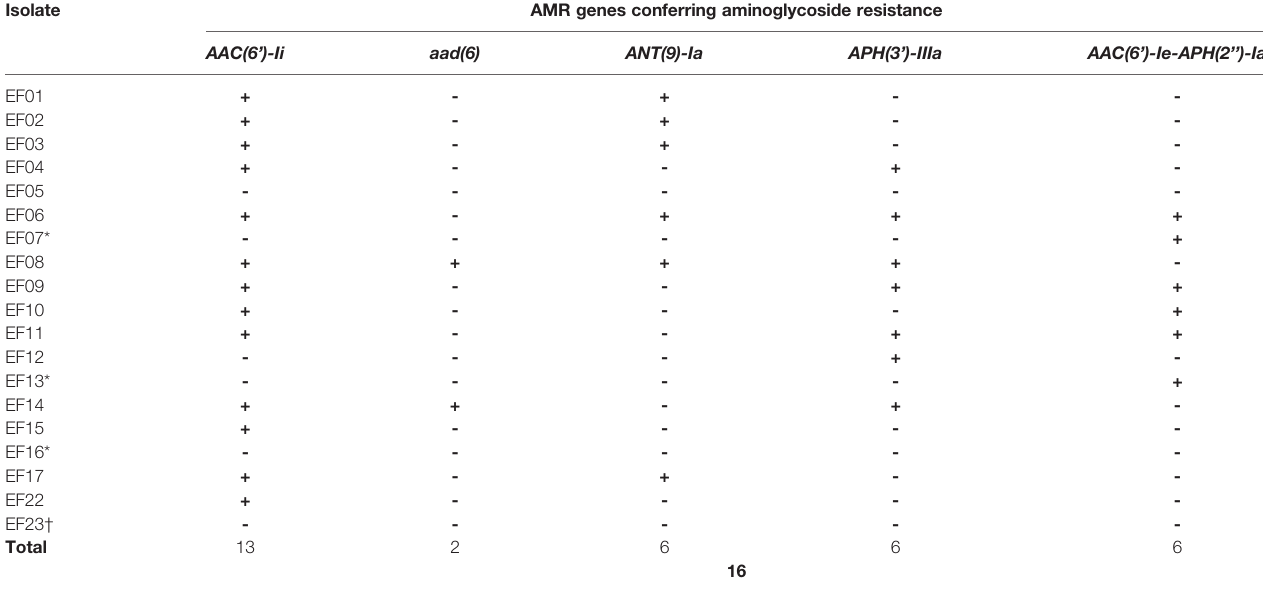
TABLE 4 | Genes detected by long-read next-generation sequencing that confer antimicrobial resistance (AMR) to aminoglycoside.